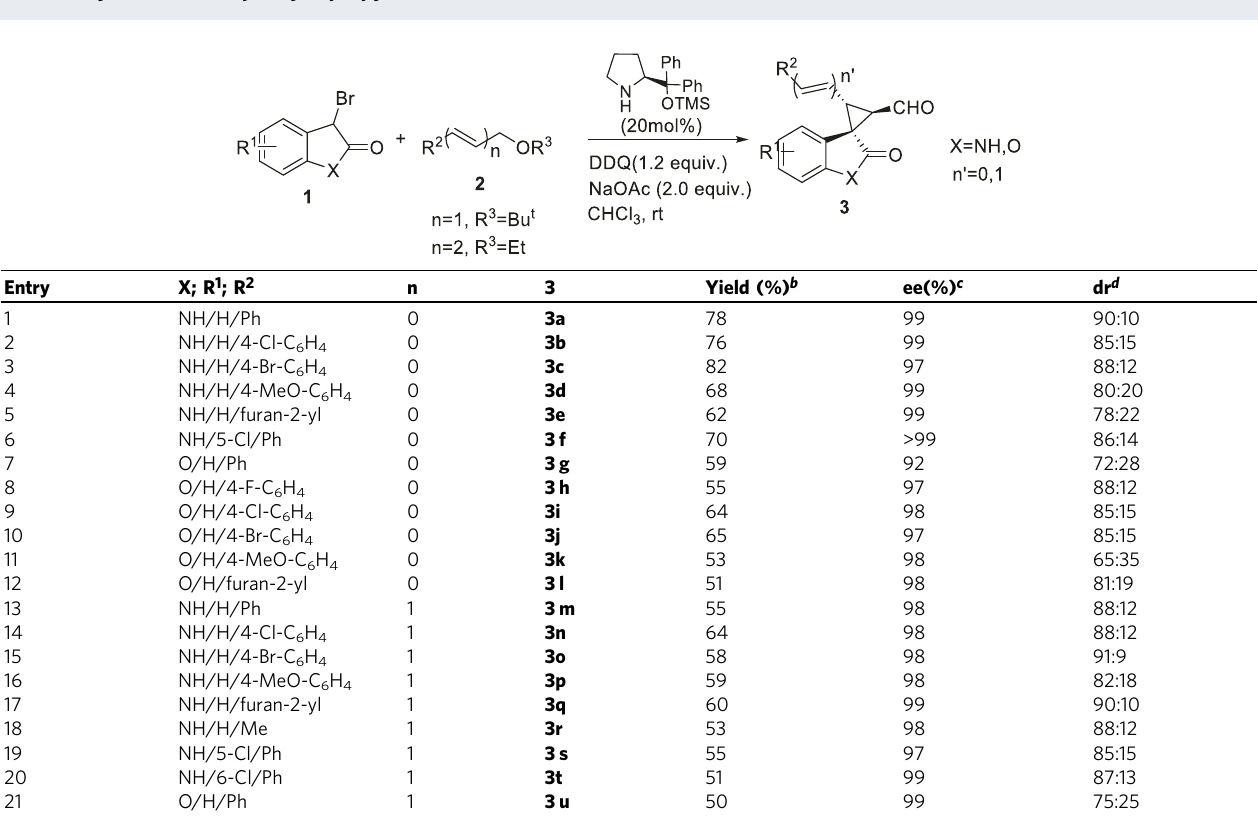
Table 2 Synthesis of 3-spirocyclopropyl-oxindoles and